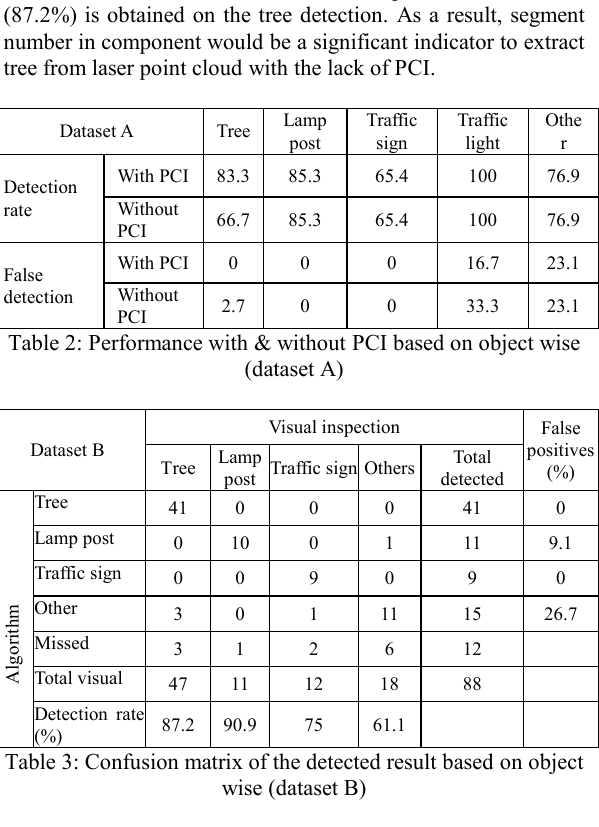
Figure 7: Result of the detection algorithm in dataset A, (a) input data (b) output classified result